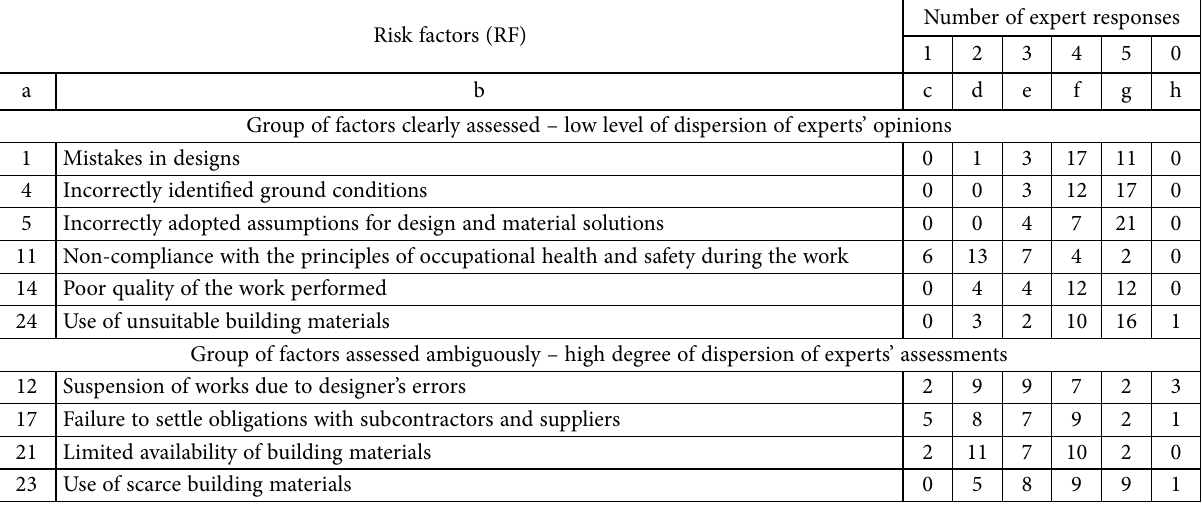
Table 8. The results of expert studies of risk impact assessment on the size of the life cycle costs of buildings, taking into account the number of responses received for each degree of impact (own study) Risk factors